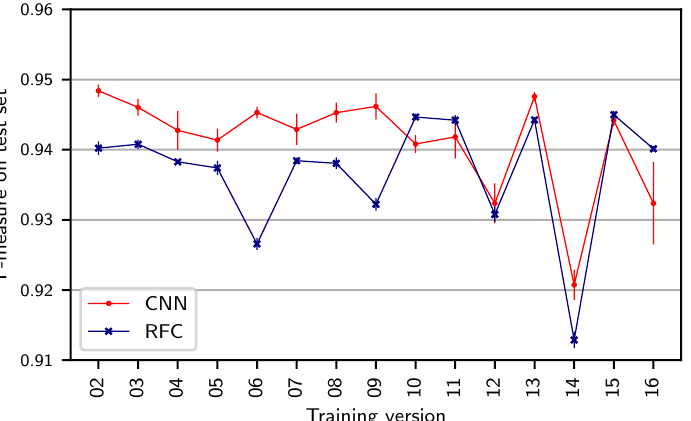
Figure 3. Results for both systems when training on different (individual) versions of the test act ( version split